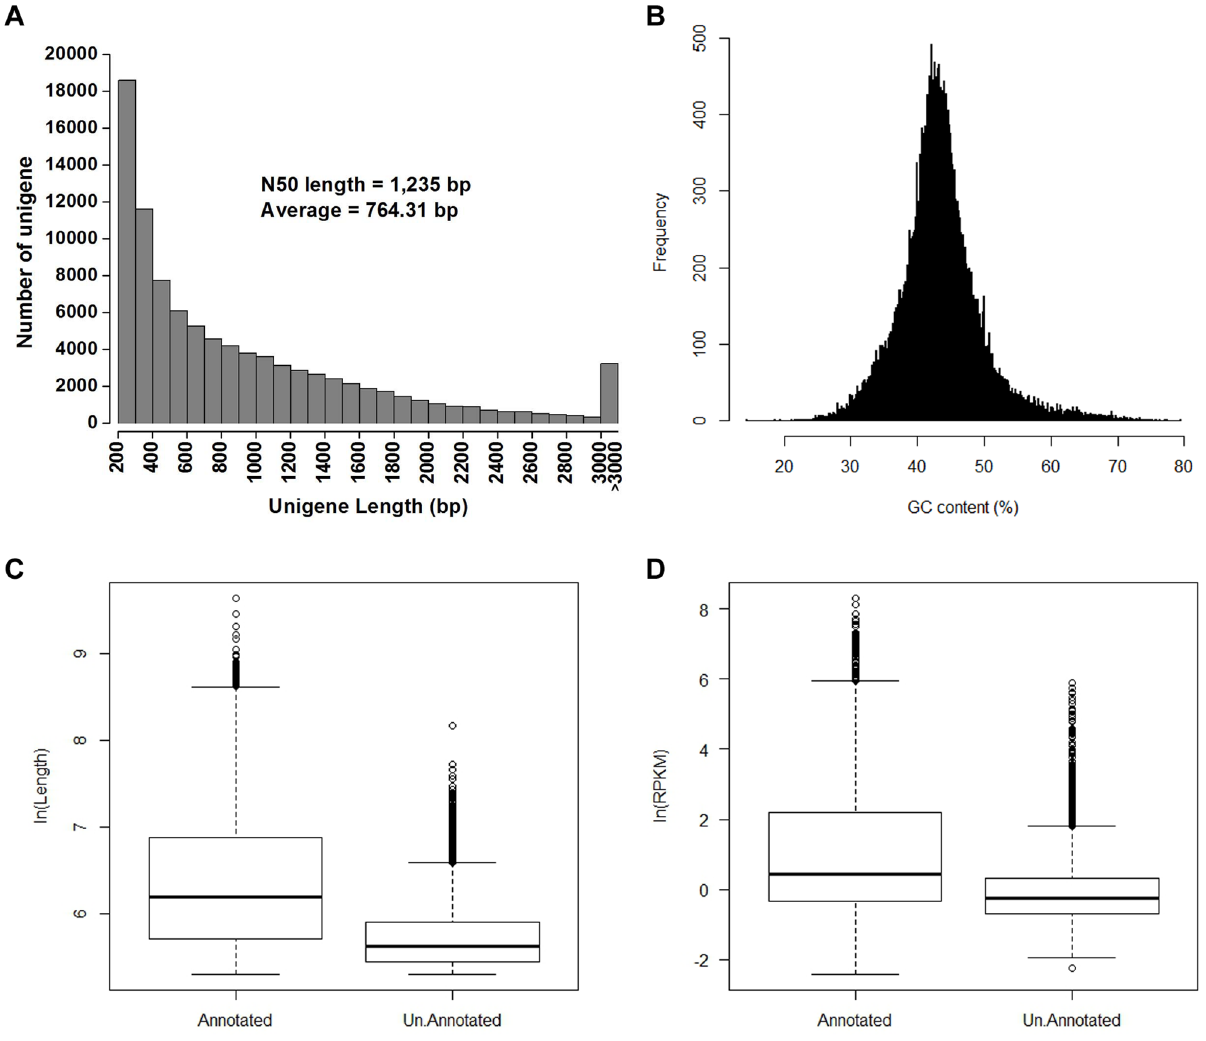
Fig 1. Analysesof the B . humilis trancriptome. (A) Histogramto show the length distribution of assembledunigenes. (B) Distributionof GC content in unigenes.(C) Length distributionof annotatedand un-annotated unigenesinferred using ln(Length).(D) Expression levels of annotatedand un-annotated unigenesinferred using ln(RPKM).